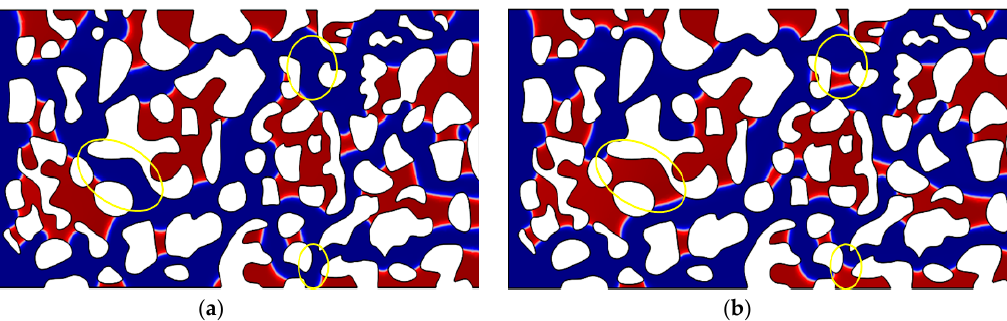
Figure 9. The oil recovery and water cut at the outlet when the surfactant is injected at different times: ( a ) oil recovery rates (Y-axis is oil recovery rate, % and X-axis is time, s) and ( b ) water cut curves (Y- axis is water cut, % and X-axis is time, s).